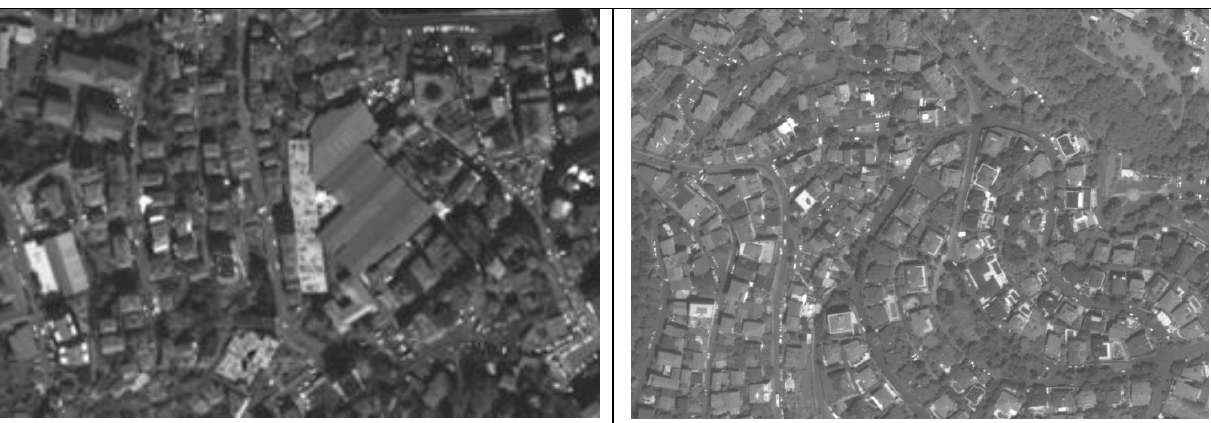
Figure 4. Panchromatic Worldview-1 image (left) , Worldview-4 image (right)